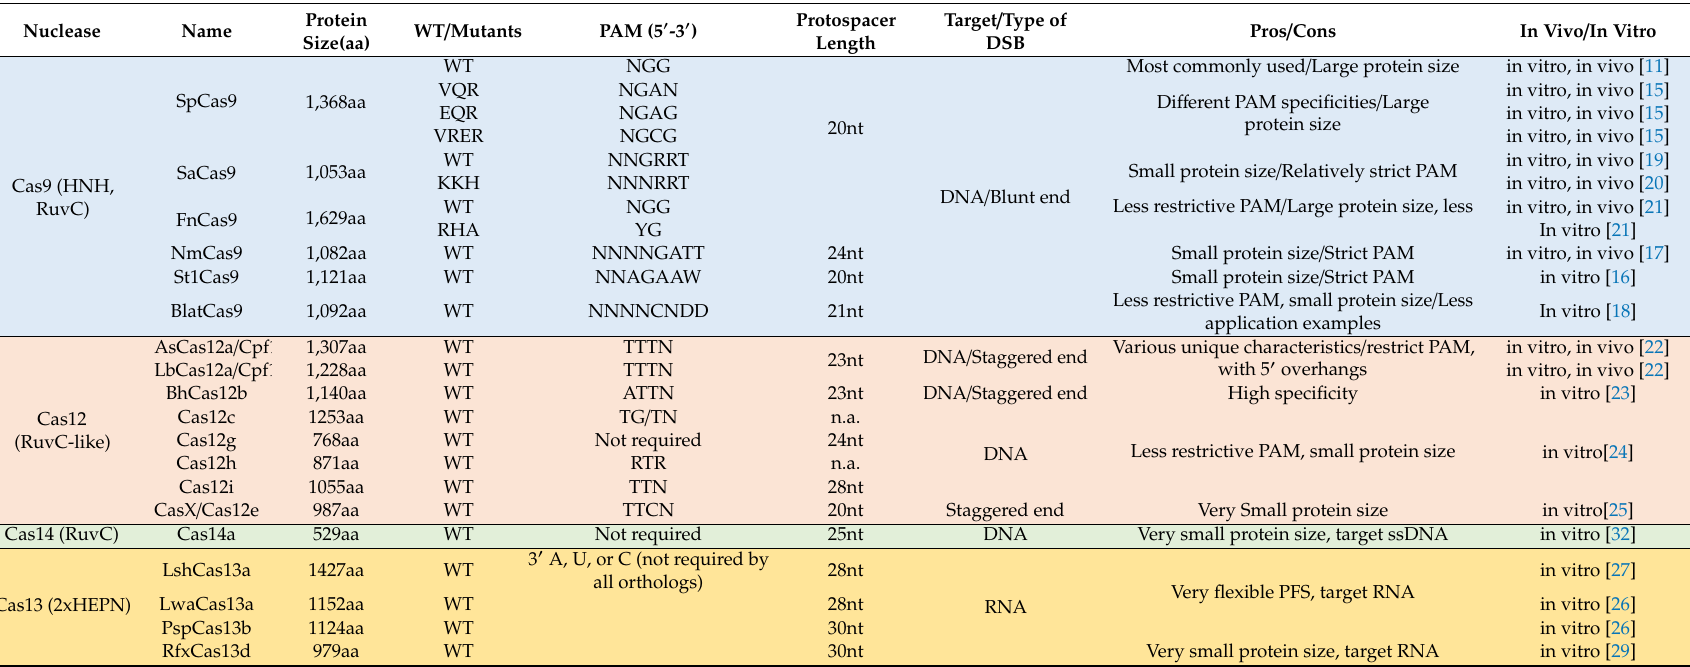
Table 2. Comparison of Cas